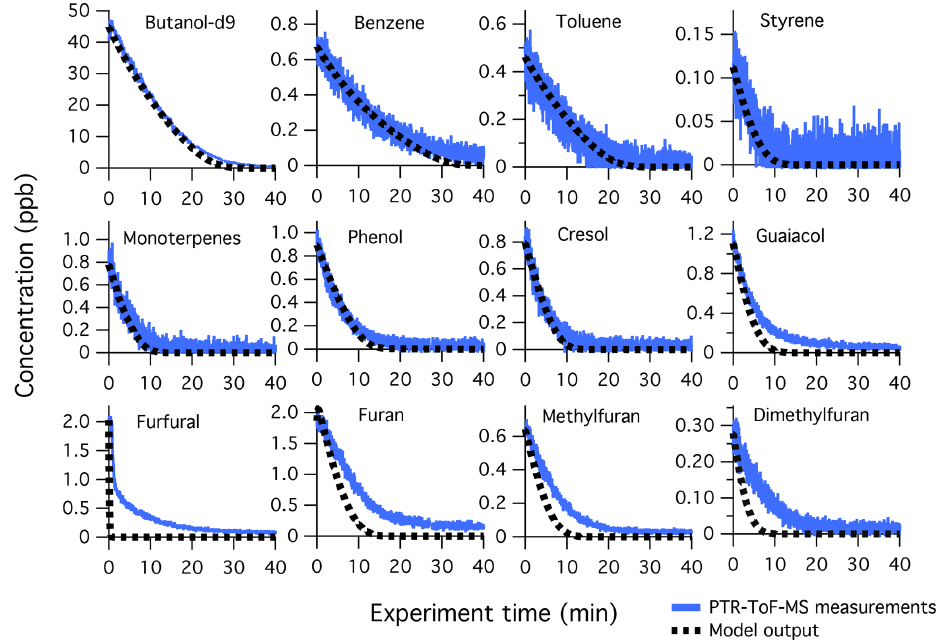
Figure 7. Primary NMOG measurements (blue lines) compared to modeled output (dotted black lines) for Fire 38. The decay of butanol-d9 is shown to demonstrate model performance in reproducing OH exposures, which was achieved by adjusting the measured photon flux by a factor of 1.5. The fuel is ponderosa pine litter, NO x /NMOG = 0.3, with a mixture of high- and low-temperature pyrolysis